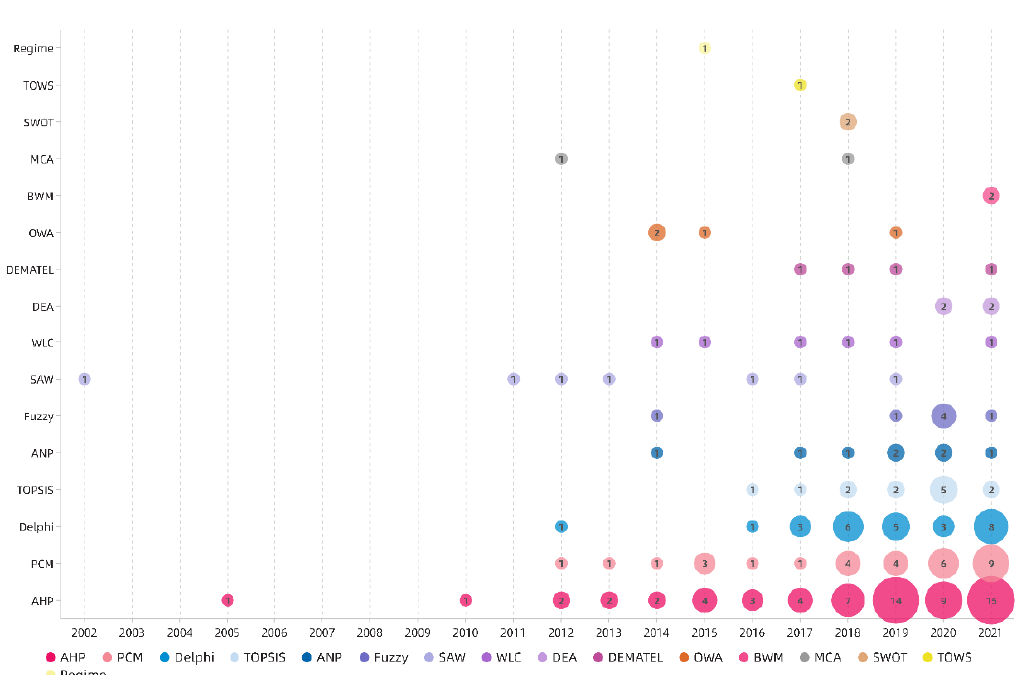
Figure 8. The annual distribution of occurrences of the MCDA methods. The size of the bubble and the number in the bubble indicate the number of times the method was used in the corresponding year.